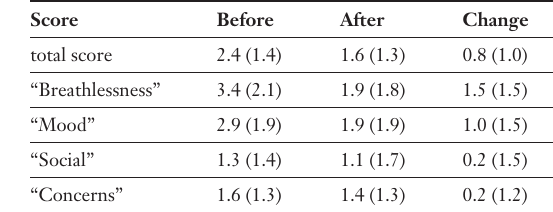
Figure 3 AQLQ-Sydney scores responsiveness to anti-asthmatic treat- ment for two months (n = 17). The fifth line from top (starting with a total score of 3.5) represents the observation of two different